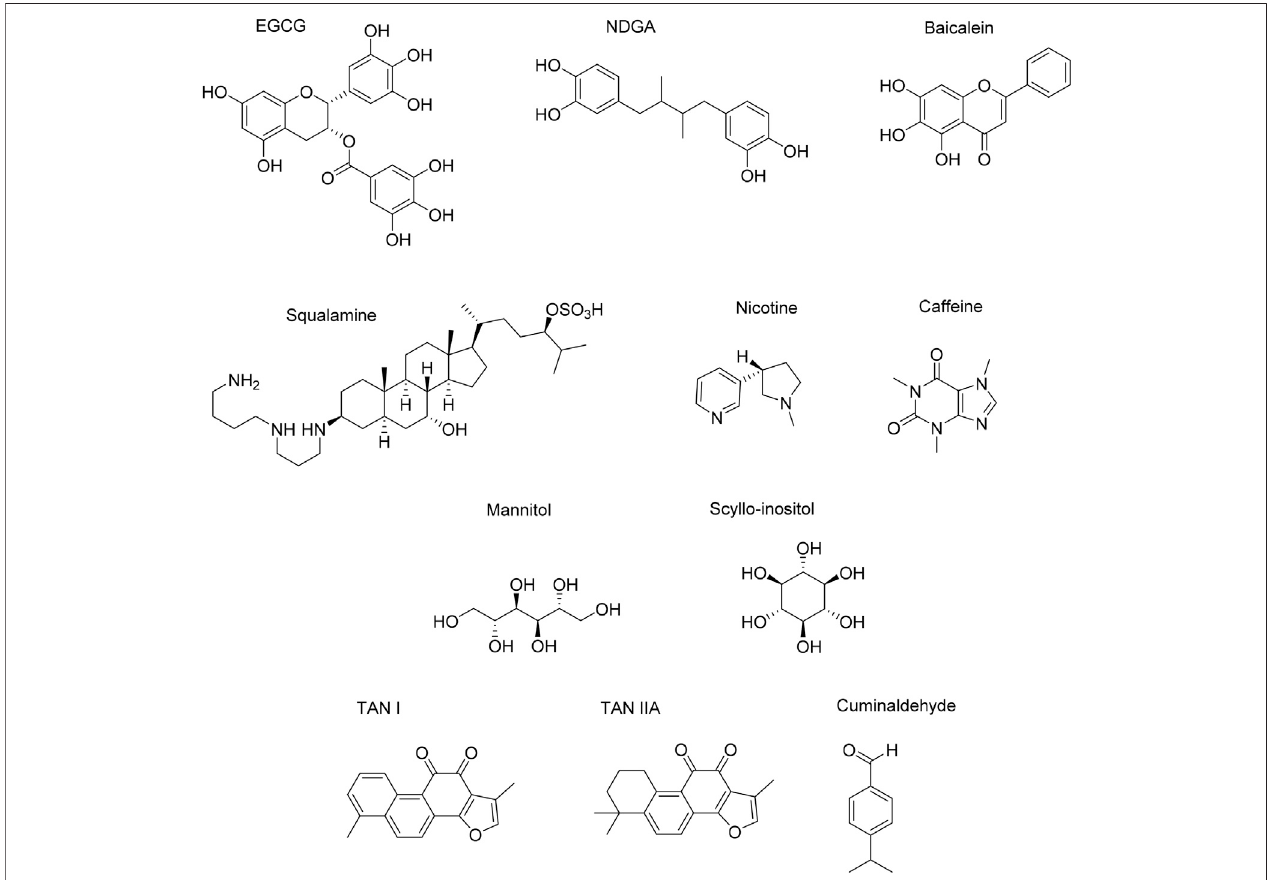
FIGURE 12 | Natural small molecules in fl uencing α Syn conformation